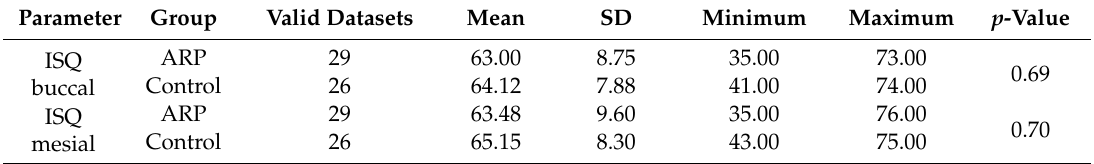
Table 7. Primary stability of the implants in the ARP group and the control